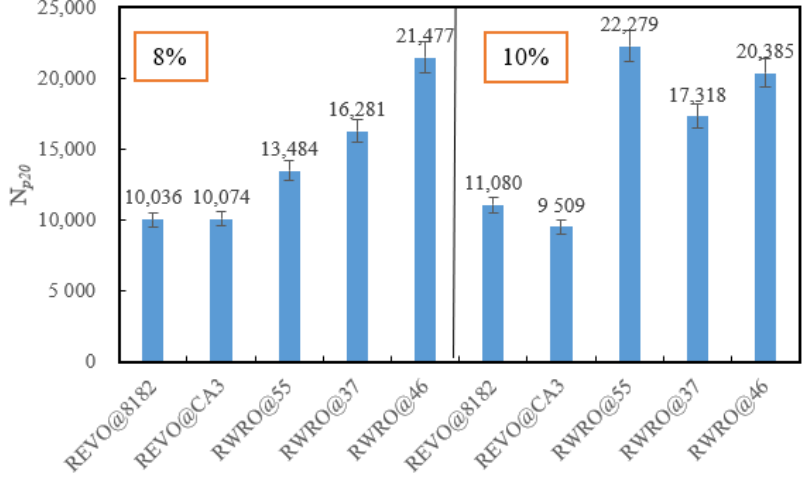
Figure 13. Fatigue life of rejuvenated asphalt.